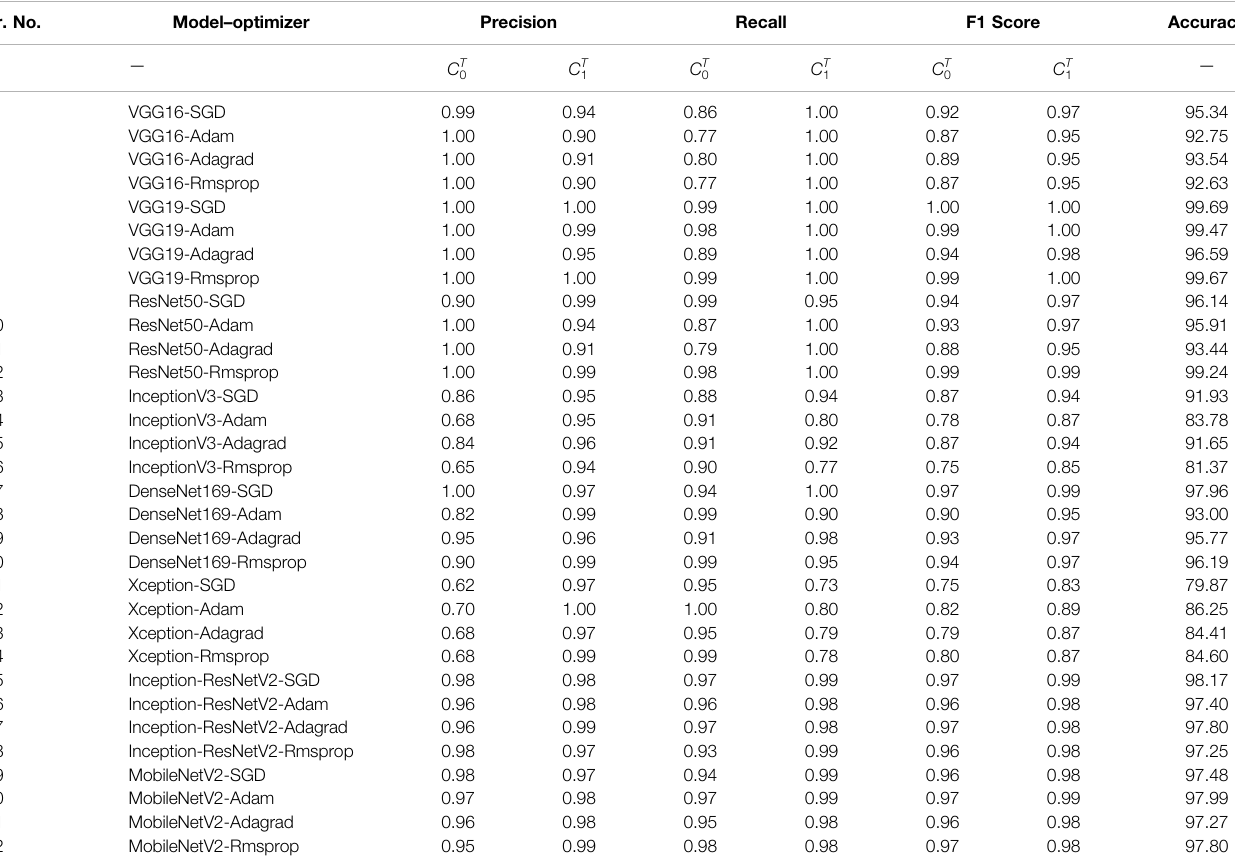
FIGURE 3 | Testing accuracies for two-class classi fi cation.